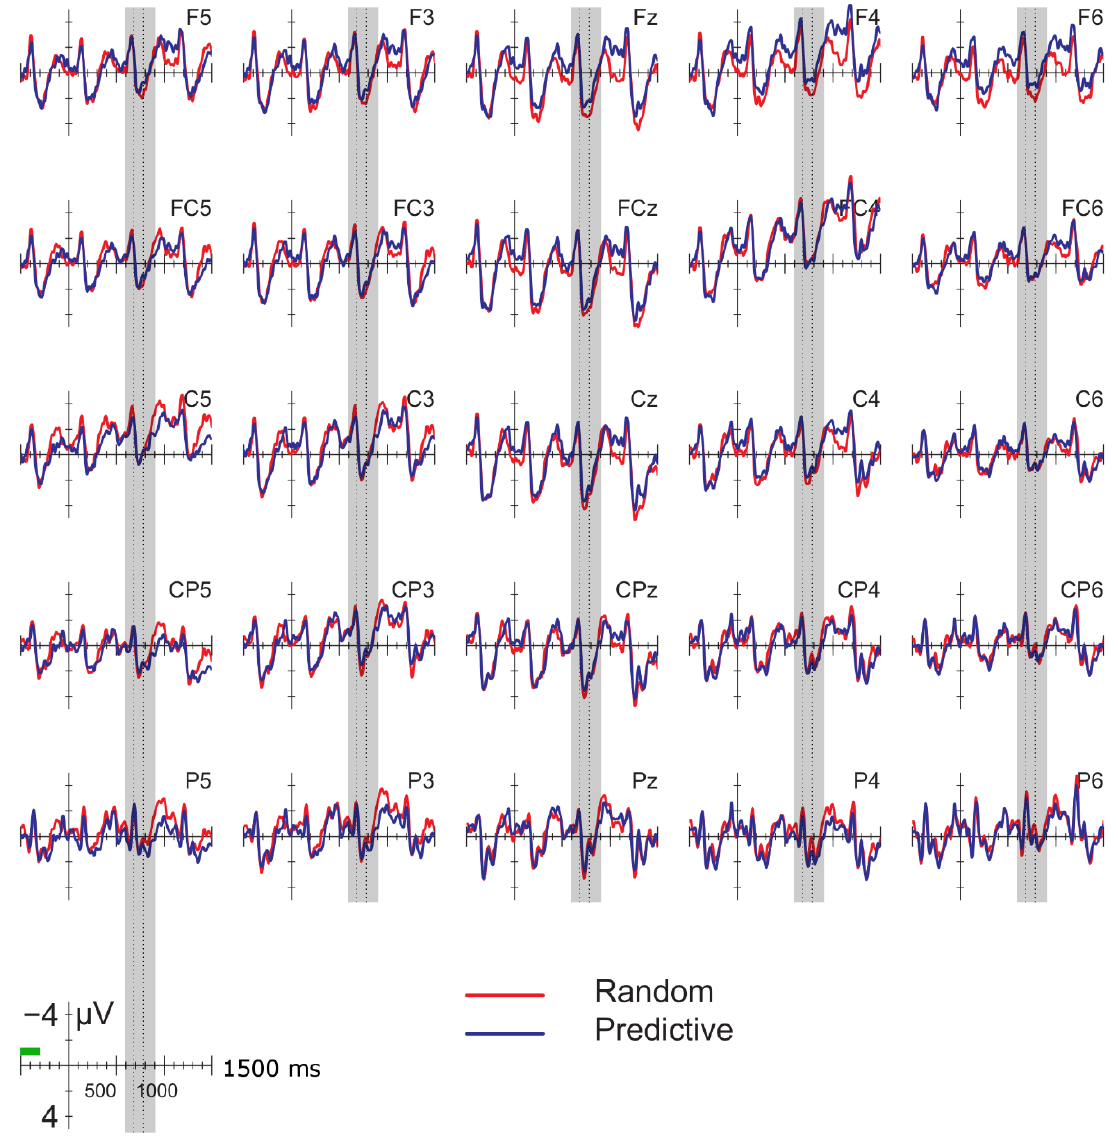
Figure 2. ERPs for the no-delay conditions, time-locked to the onset of the letter equivalent in position to the pre-delay letter in Figure 1. The next letter starts at 500 ms. Blue line: predictive (alphabetic) condition; red line: random condition. ERPs are baselined to the −500 to −300 ms interval (green bar). Gray vertical bar: 600–900 ms interval used in the analysis of the delay effects; vertical dotted lines: analysis window for the P2/P3